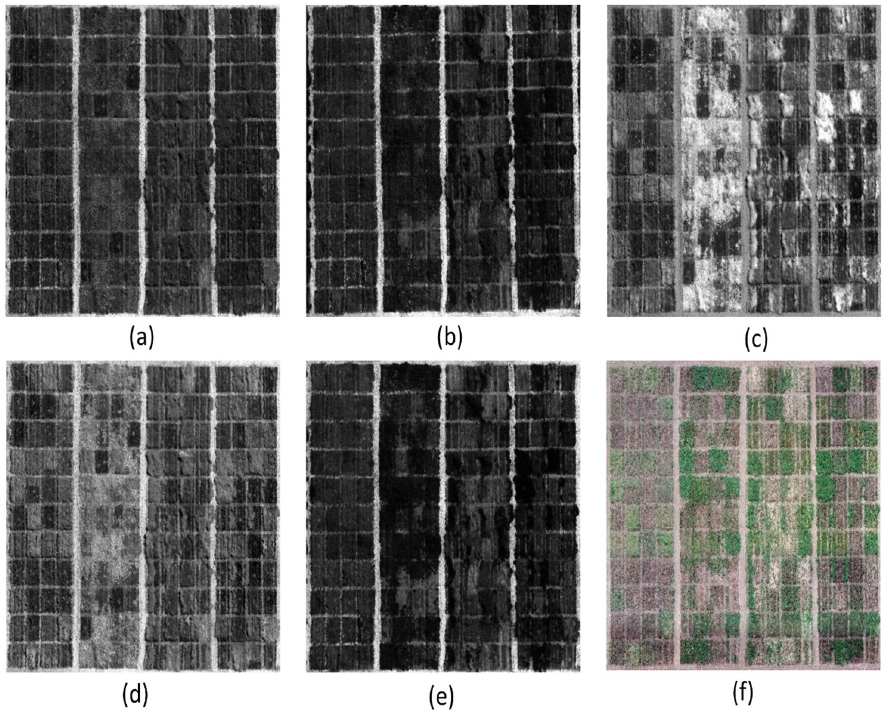
the overlapping points in the images and geo-rectifying images, (2) densifying the point cloud and generating mesh, and (3) generating digital surface model (DSM) and orthomosaicing images. Polygon with the ground size of 2.13 m × 3.35 m was generated for each experimental plot in collected imagery using QGIS 3.16 Hannover (QGIS Geographic Information System, Open-Source Geospatial Foundation Project). Each plot polygon was buffered by excluding 30 cm on all four sides to account for the edge effects. Reflectance values for all five bands (exam- ple, Fig 4) were then extracted from each plot polygon using the “Zonal Statistics as